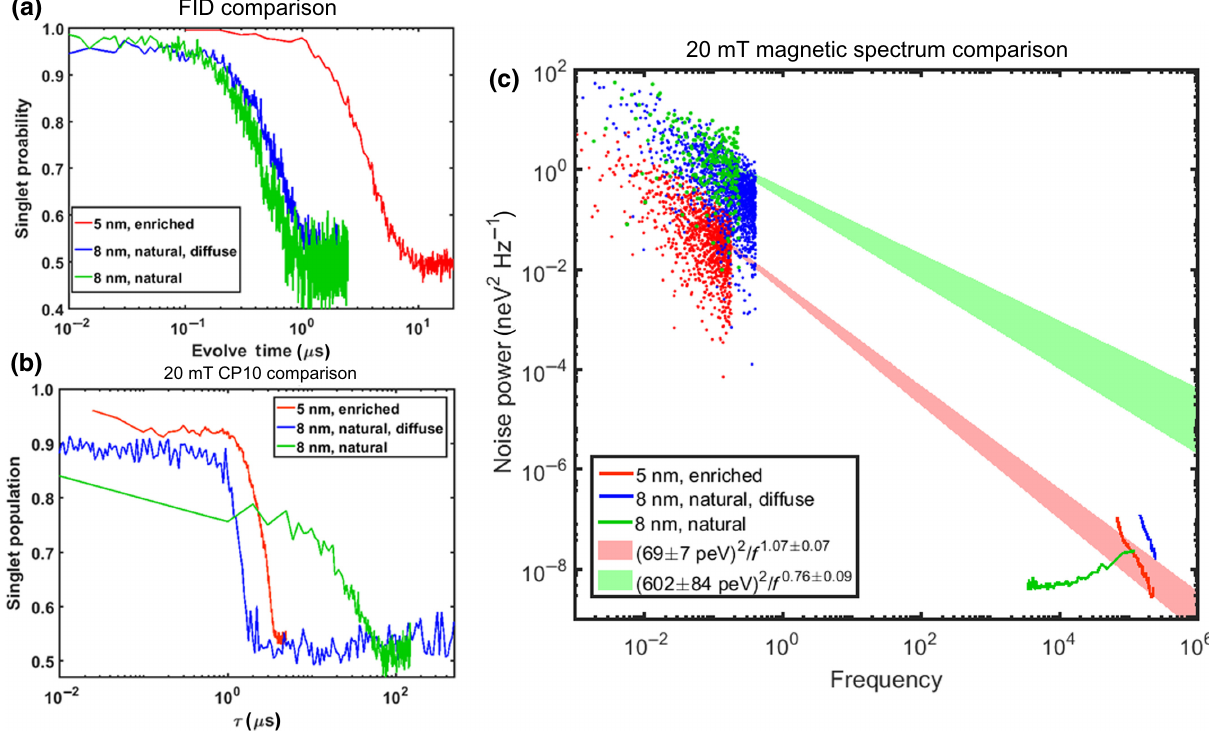
FIG. 8. (a) FID experiments of the same devices at a few millitesla, showing that the 29 Si isotopic content has the largest contribution . (b) CP10 decay experiments from three devices of differing material epitaxy, with 20 mT magnetic field, showing that the Si/SiGe to T ∗ 2 interface has the largest contribution to CP10 decay. (c) Comparison of spectral estimates from FID and CP10 experiments in 20 mT fields, as well as extrapolation of power law fits to 5 and 8 nm low-frequency